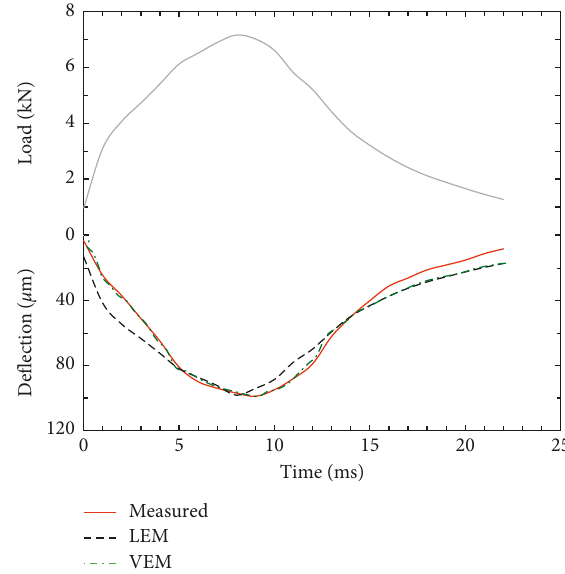
Figure 9: Comparison of measured and back-calculated deflection- time curves of L4.